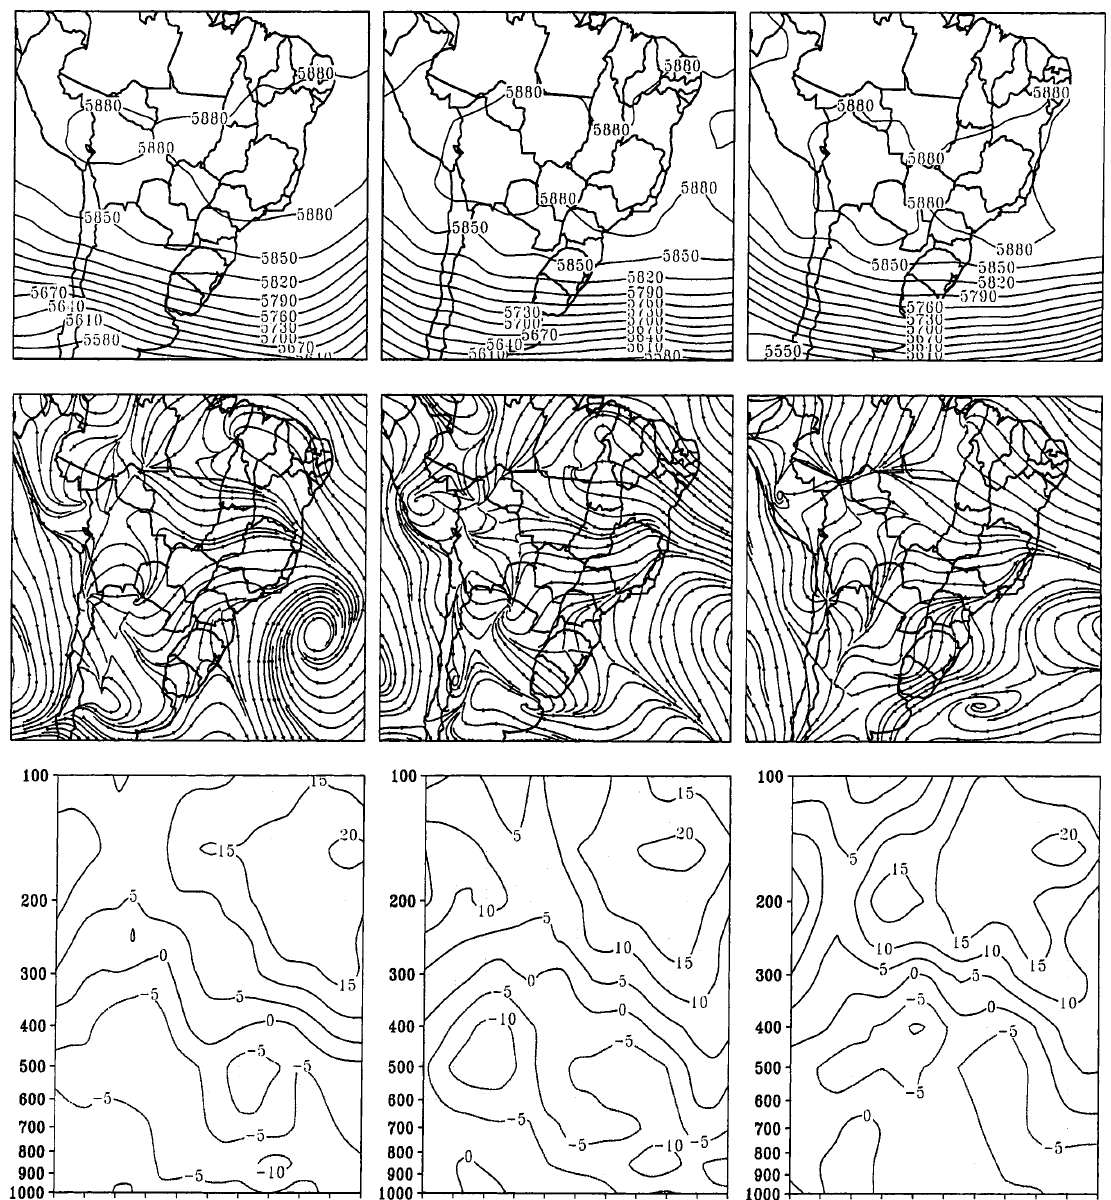
Fig. 1. Upper panel : 500 hPa geopotential; middle : streamlines at 1000 hPa; lower : vertical cross section along 12.5 (cid:176) S of the zonal wind component. Columns from left to right : 19, 20 and 21 August, 1994, 12